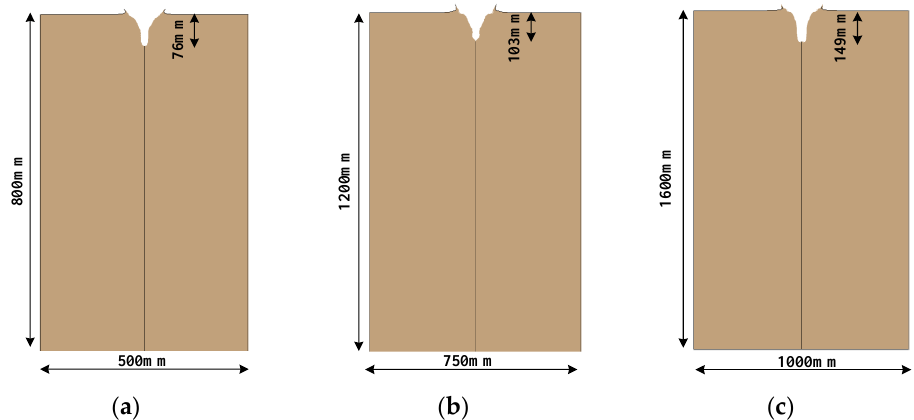
Figure 13. Charge diameters with liner angles of 150°: ( a ) 50 mm; ( b ) 75 mm; ( c ) 100 mm.